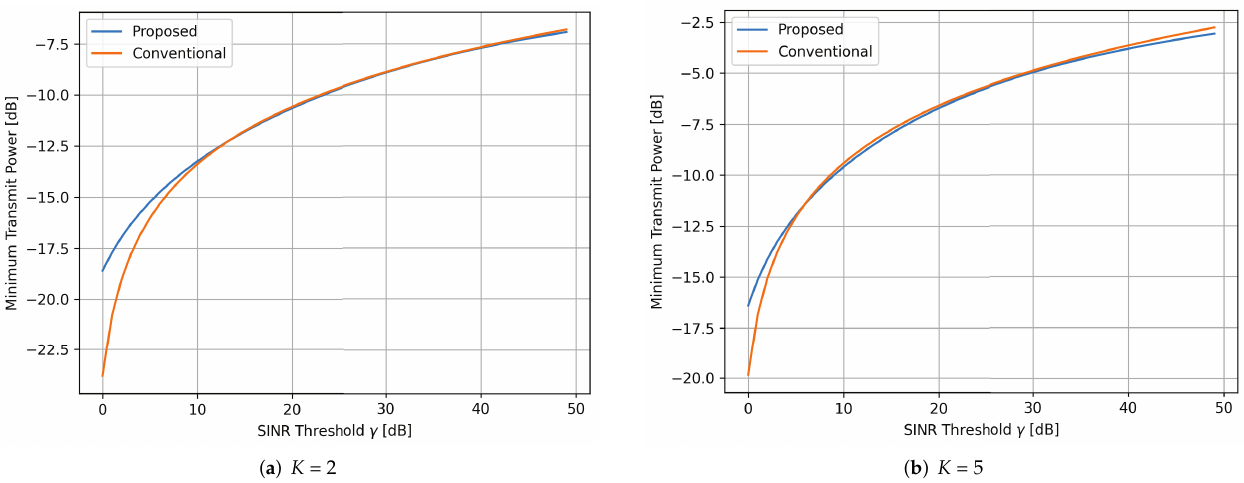
Figure 9. Minimum transmit power versus the SINR threshold for the uplink with v = 300